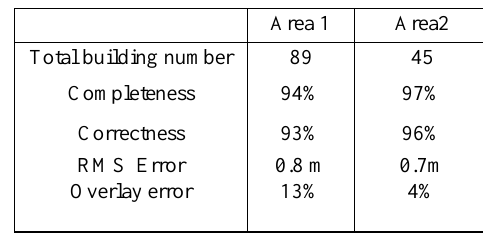
Table 2. The accuracy assessments for building